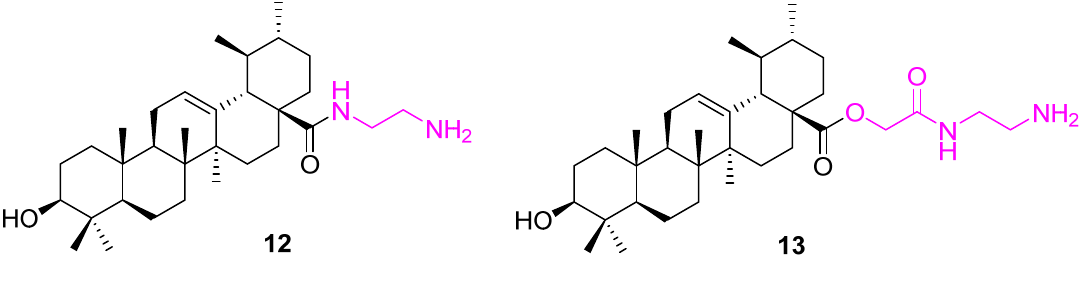
Figure 9. Structure of 12 , 13 .